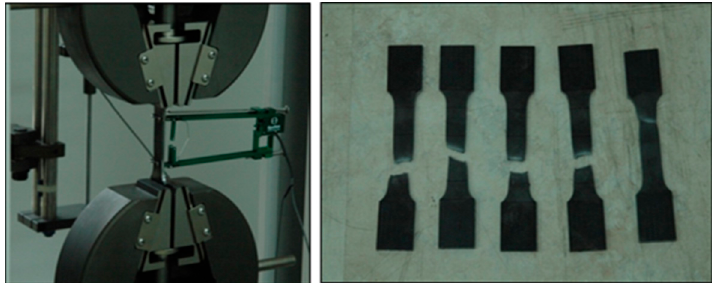
Figure 8. Tensile test specimen of the same material as that of the model used in the experiment. Table 5. Tensile test results.